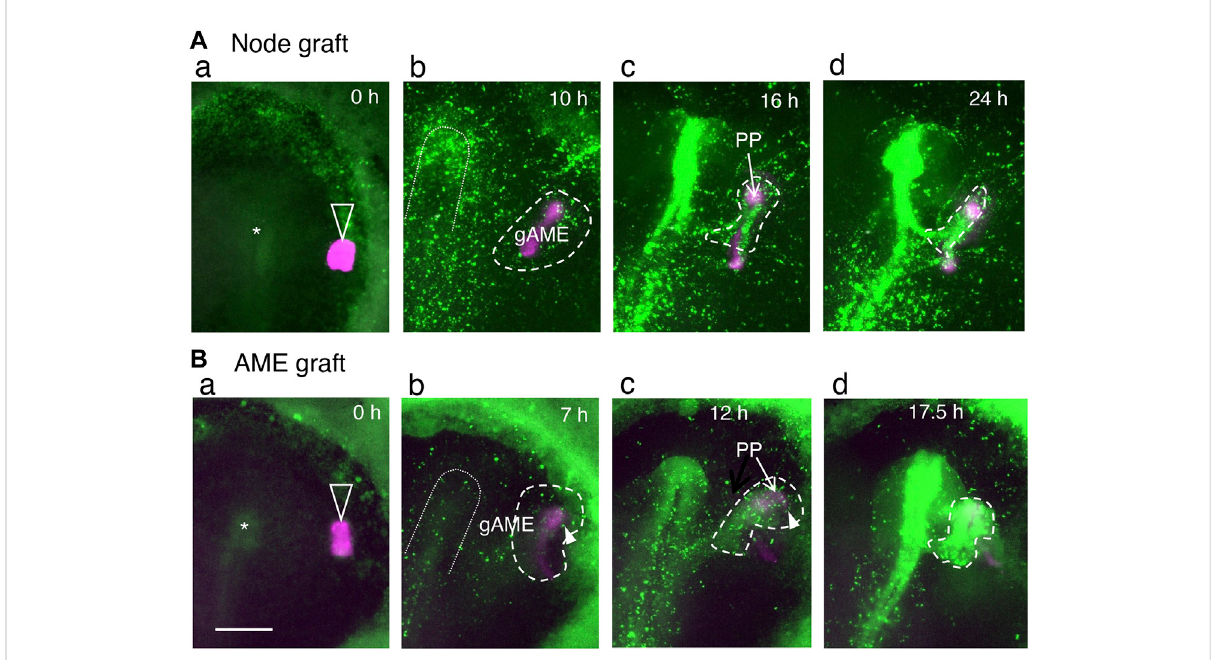
FIGURE 5 AMEsextendedfromthegraftedst.4nodeorisolatedst.5AMEelicitsthegatheringofsurroundingepiblastcells,whichdevelopintosecondary brain tissues, as indicated bylive imaging ofthe fl uorescent-labeled epiblastand node/AME. Adopted from (B,D) of Yoshihi et al. (2022). The anterior sideisatthetop.Openarrowheads indicatethenode/AMEgrafts(magenta);asterisksindicatethehostnodes.Brokenlinesencircletheepiblastcells gatheringaroundthegAMEandformingsecondarybraintissues.TheinvertedU-shapesindottedlinesindicatetheprimaryneuralplateregions attheprospectiveandformingstages. (A) GraftinganmCherry-expressingquailnodeatalateralpositionoftheEGFP-labeledhostepiblast.Excerpts from Supplementary Movie S5. (B) Grafting a st. 5 quail AME isolated according to Qiu et al. (1998). Excerpts from Supplementary Movie S6. The periods in the culture are indicated in panels. (a) The stage when the quail node/AME was grafted. (b) The graft-derived AME (gAME) elongated and elicited the gathering of nearby epiblast cells (encircled by broken lines). (c) The gAME tissue differentiated into the PP (indicated by an arrow) and ANC (covered by EGFP fl uorescence). The head precursors that converged on gAME started to form secondary brain tissues (encircled by broken lines). (d) The secondary brain (encircled by broken lines) fused to the primary brain at the posterior end in these specimens. Arrowheads in (b,c) indicate the contribution of cells derived from area opaca to the secondary brain tissue. Scale bar, 500